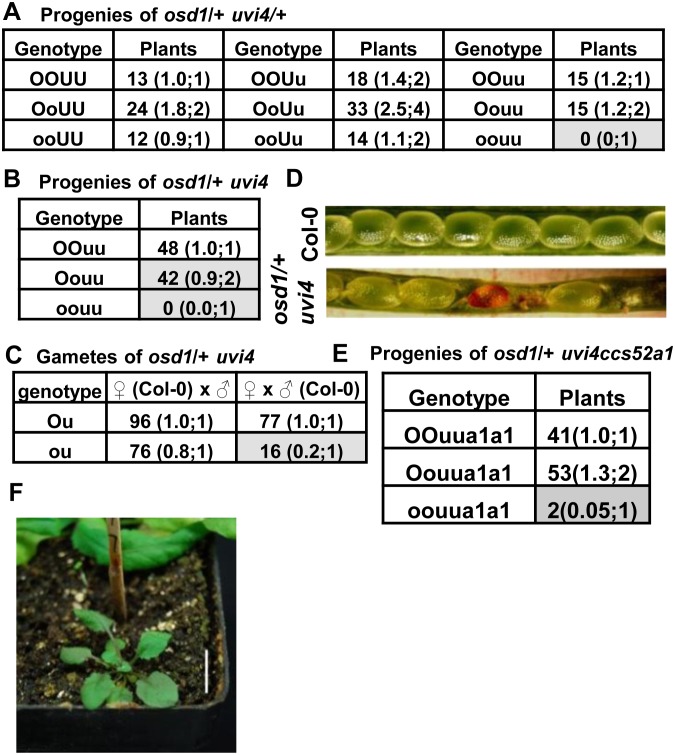

CCS52A1 partially mediates the lethality of osd1 uvi4.Shown are numbers of plants of each genotype in an analyzed population. The two numbers separated by a semicolon in parentheses are the observed ratios of that genotype relative to the top left genotype (left) and the expected ratios when there is no reduced transmission of the gametes or zygotes (right). (A) Analysis of progenies of osd1/OSD1 UVI4/uvi4. No osd1/osd1 uvi4/uvi4 plants (shaded) were found. The difference between observed and expected segregation ratio was determined by chi-square test (P = 0.004<0.05). (B) Analysis of progenies of osd1/OSD1 uvi4/uvi4. Notice that both OSD1/OSD1 uvi4/uvi4 and osd1/OSD1 uvi4/uvi4 (shaded) were about half of expected and there were no osd1/osd1uvi4/uvi4 (shaded) progenies produced. The significance was determined by chi-square test (P = 6.24E-12<0.05). (C) Analysis of gamete transmission inferred from reciprocal crosses between osd1/OSD1 uvi4/uvi4 and Col-0. The osd1 uvi4 genotype had a lower transmission rate through female gametes (shaded) but not male gametes. The significance was determined by chi-square test (male, P = 0.13>0.05; female, P = 2.53E-10<0.05). (D) Opened siliques from wild-type Col-0 (upper) and osd1/OSD1 uvi4/uvi4 (lower) plants. Aborted ovules and embryos can be seen in the mutant silique. (E) Analysis of progenies of osd1/OSD1 uvi4/uvi4 ccs52a1/ccs52a1. Notice that two osd1/osd1 uvi4/uvi4 ccs52a1/ccs52a1 plants (shaded) were found. (F) Morphology of the osd1/osd1 uvi4/uvi4 ccs52a1/ccs52a1 triple mutant plant.